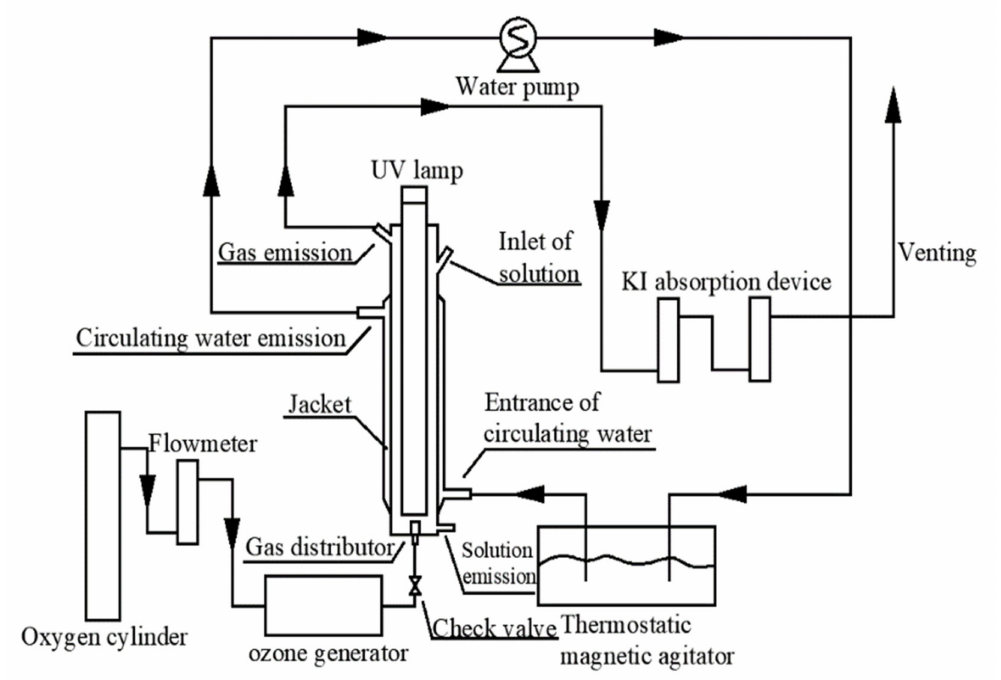
Figure 1. Schematic diagram of the UV/O 3 synergistic reaction